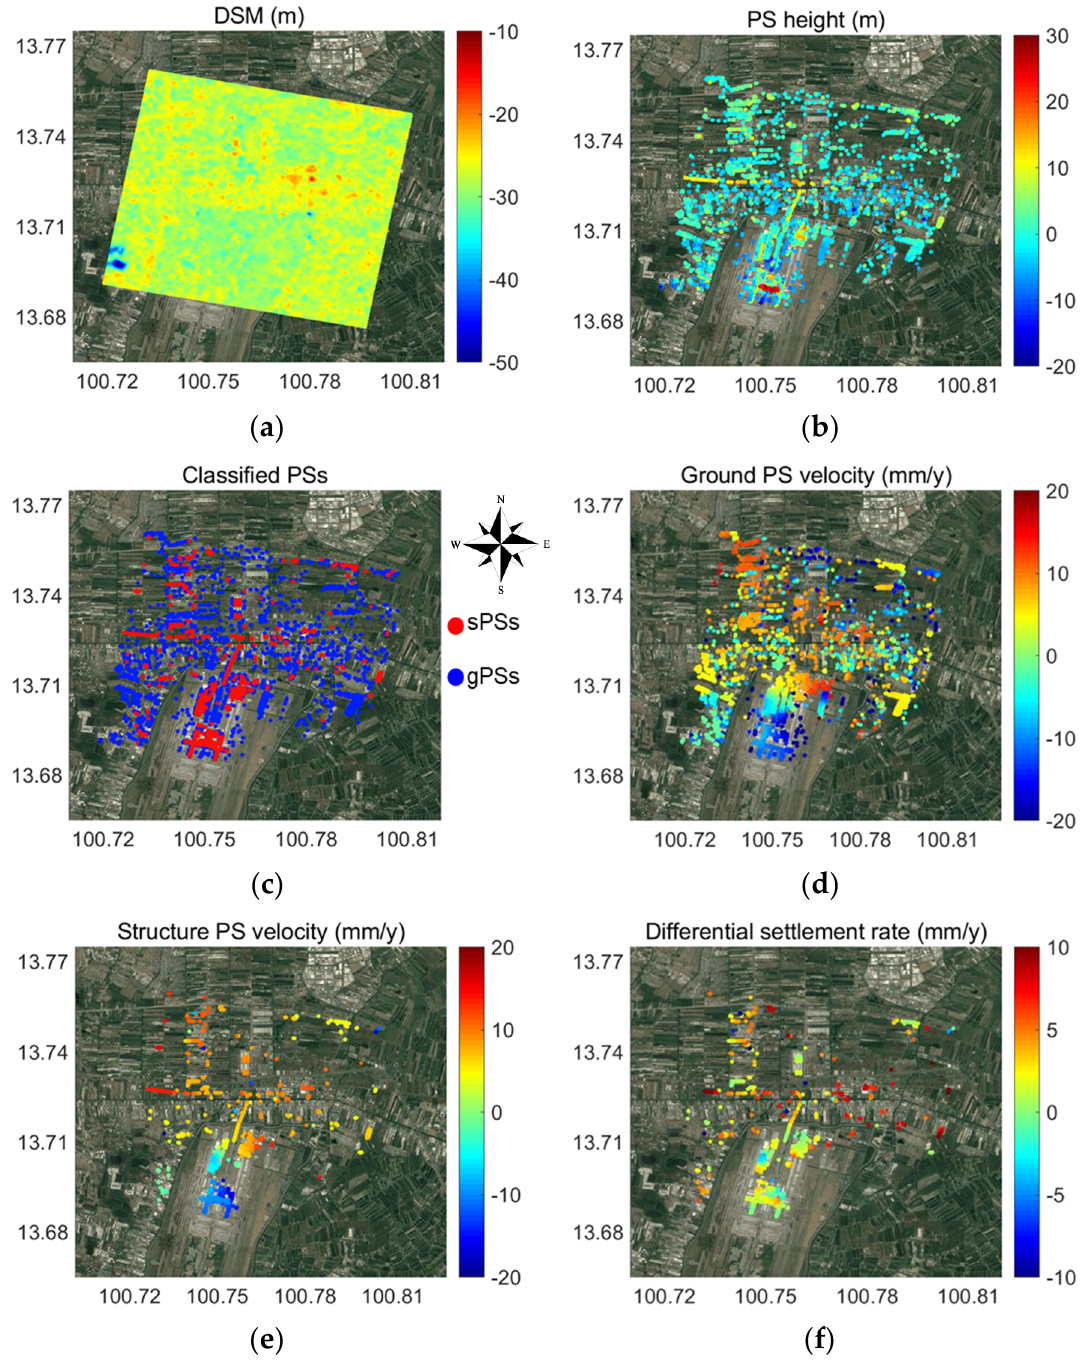
Figure 3. Enlarged maps for Area A. ( a ) Digital surface model (DSM); ( b ) PS height; ( c ) classified PSs; ( d ) gPS velocity; ( e ) sPS velocity; and ( f ) DS rate. In ( c ), red and blue points denote sPSs and gPSs, respectively. The background images used in the panels were provided by Google [30] and Copernicus.